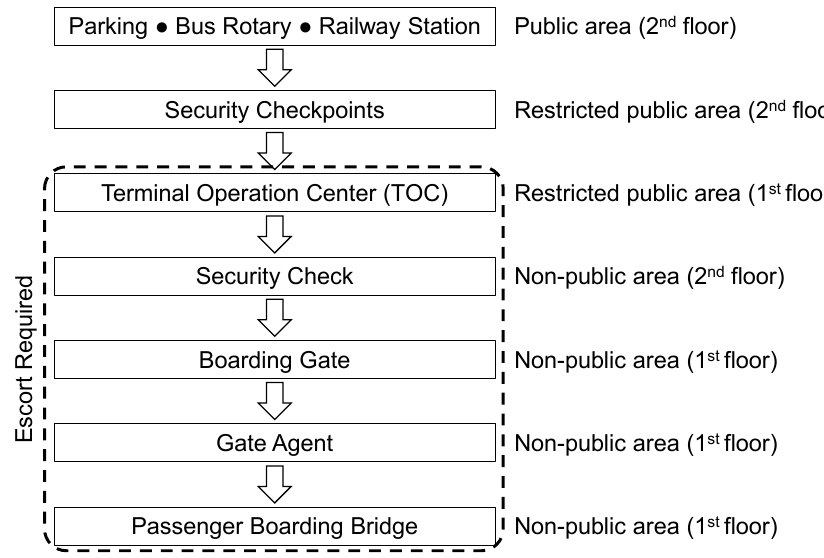
Figure 2. Flow chart of daily access to the study site.